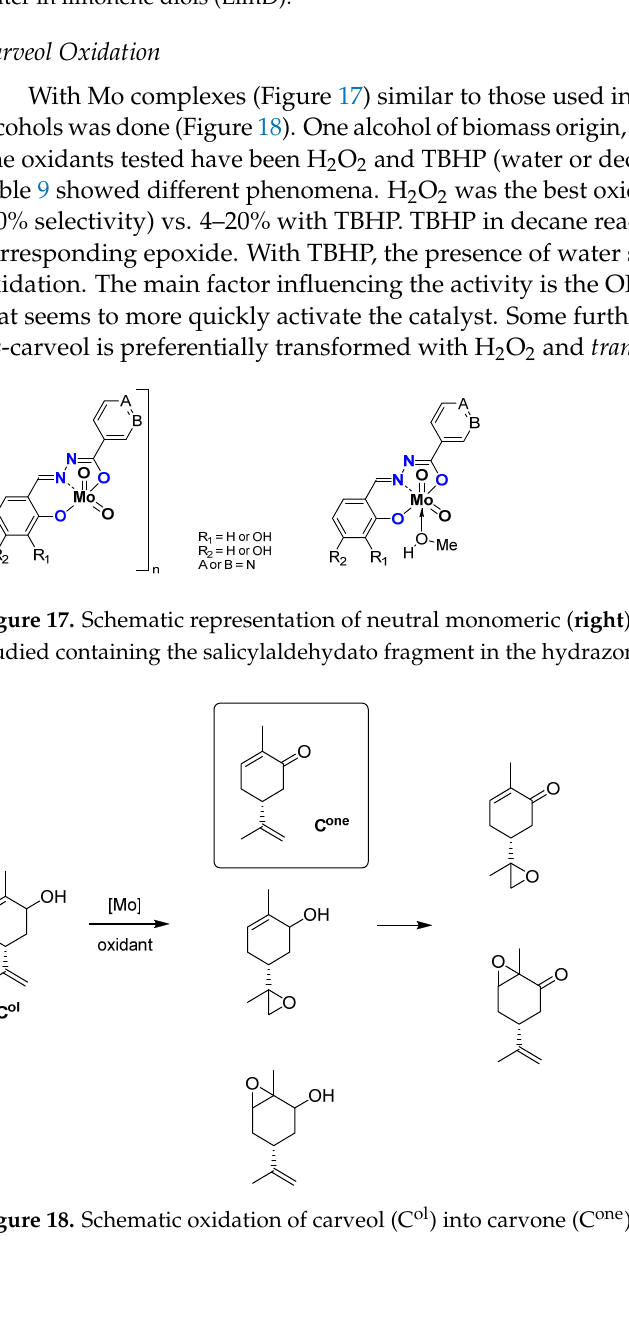
Figure 16. Schematic epoxidation of limonene (Lim) into epoxides (LimO) and water opening with water in limonene diols (LimD).